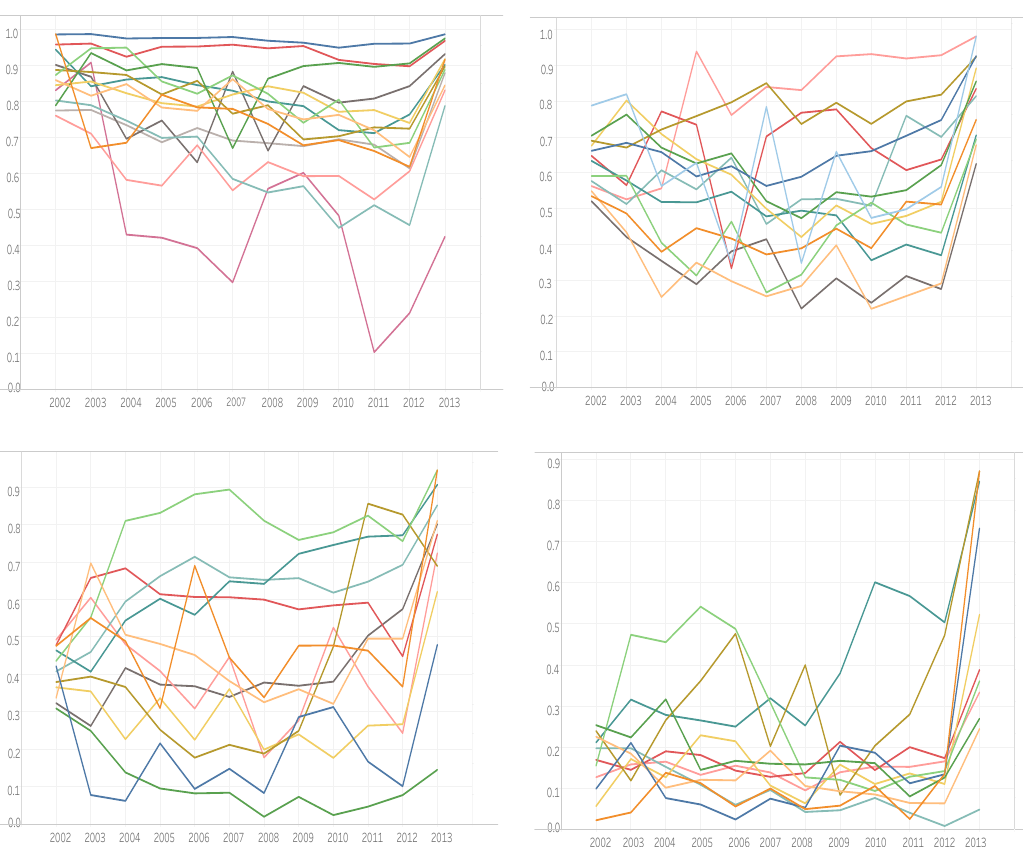
Figure 5. Behavior of the journals by quartiles (Q) in the list of applied physics. ( top-left ) Q1; ( top-right ) Q2; ( bottom-left ) Q3; and ( bottom-right )